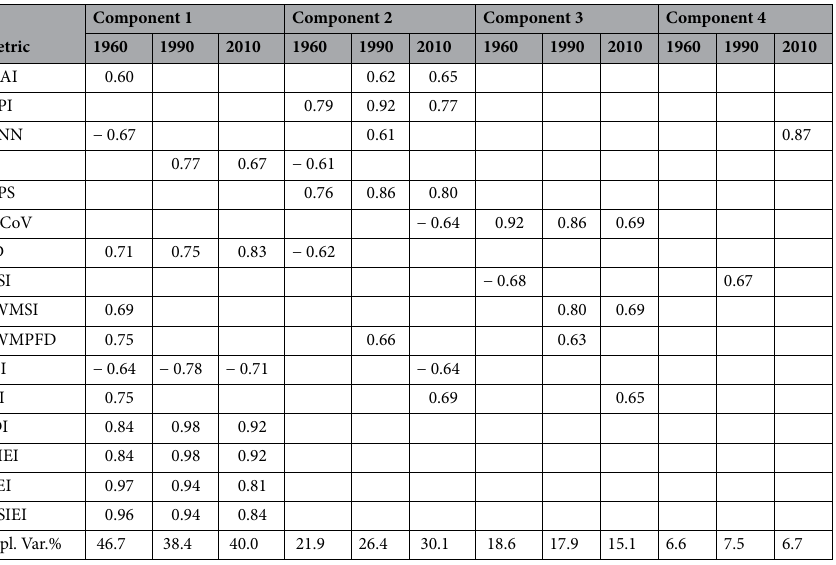
Table 4. Results (loadings) of a Principal Component Analysis run on the full set of landscape metrics (see Table 1 for acronyms) considered in this study at the regional scale in Italy, by